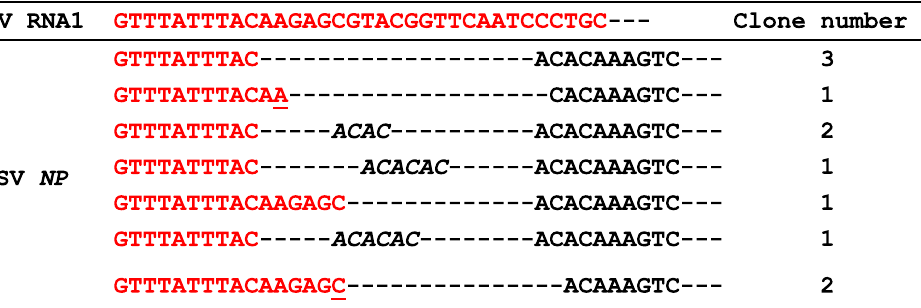
Table 1 The sequences of RSV NP mRNAs produced in vitro